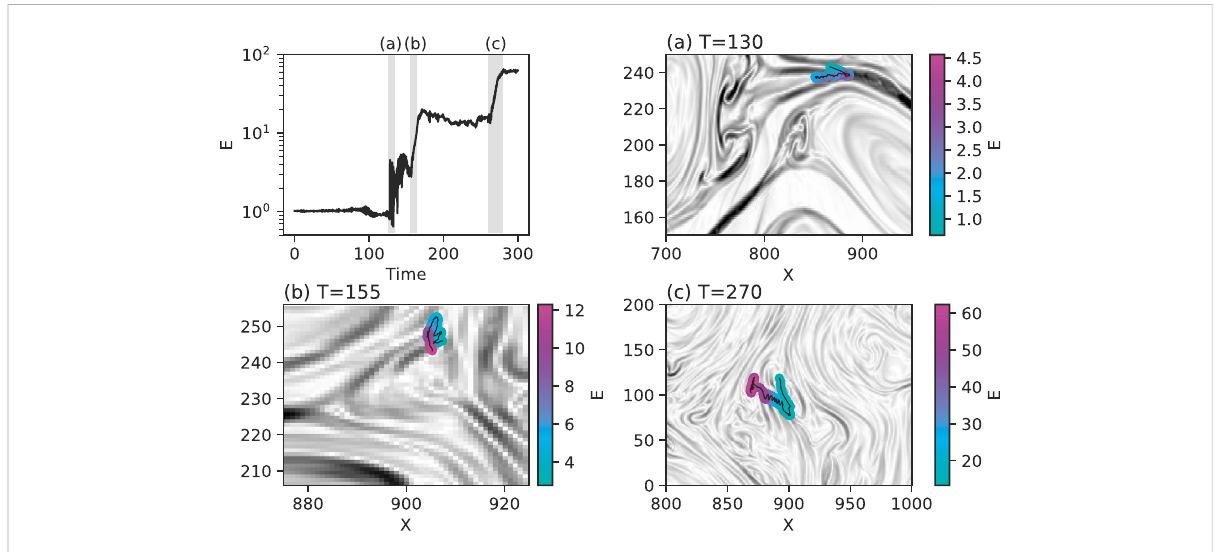
FIGURE 5 A typical tranjectory of an accelerated particle in the 2D case. Top-left panel: time evolution of the particle energy, (A) - (C) : particle trajectory (black line) and corresponding energy (color map) in the background of the current density J z (grey scale). Times (A) - (C) correspond to the shaded region in the top-left panel.